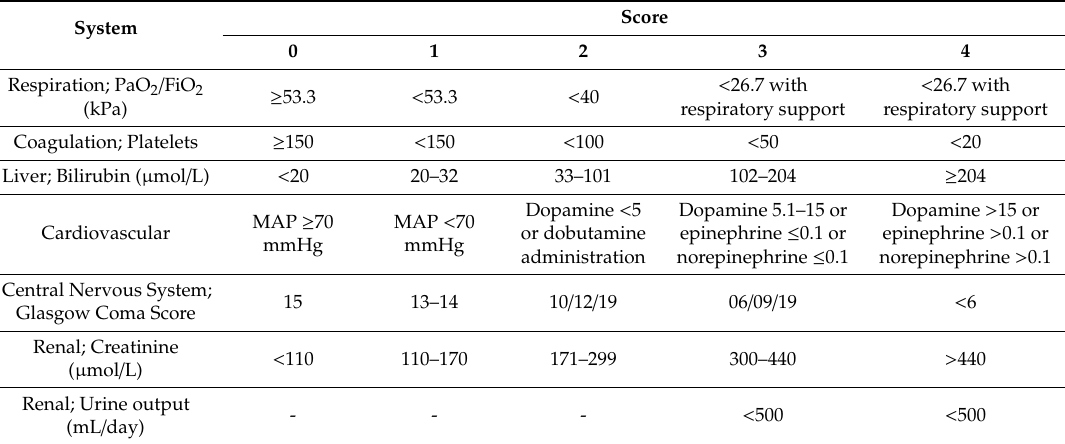
Table 4. SOFA scoring system, adapted from Singer et al., 2016